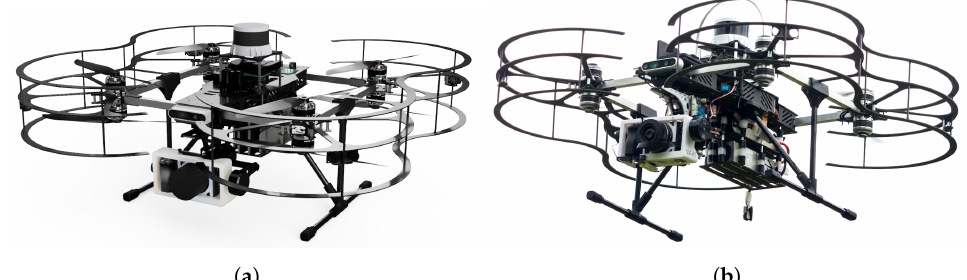
Figure 1. The hardware platform application-tailored for deployment in interiors of historical structures. The platform is designed with a high emphasis on motor and sensory redundancy, robust and stable flight, and minimal dimensions with maximal payload weight. ( a ) CAD model. ( b ) Real-world